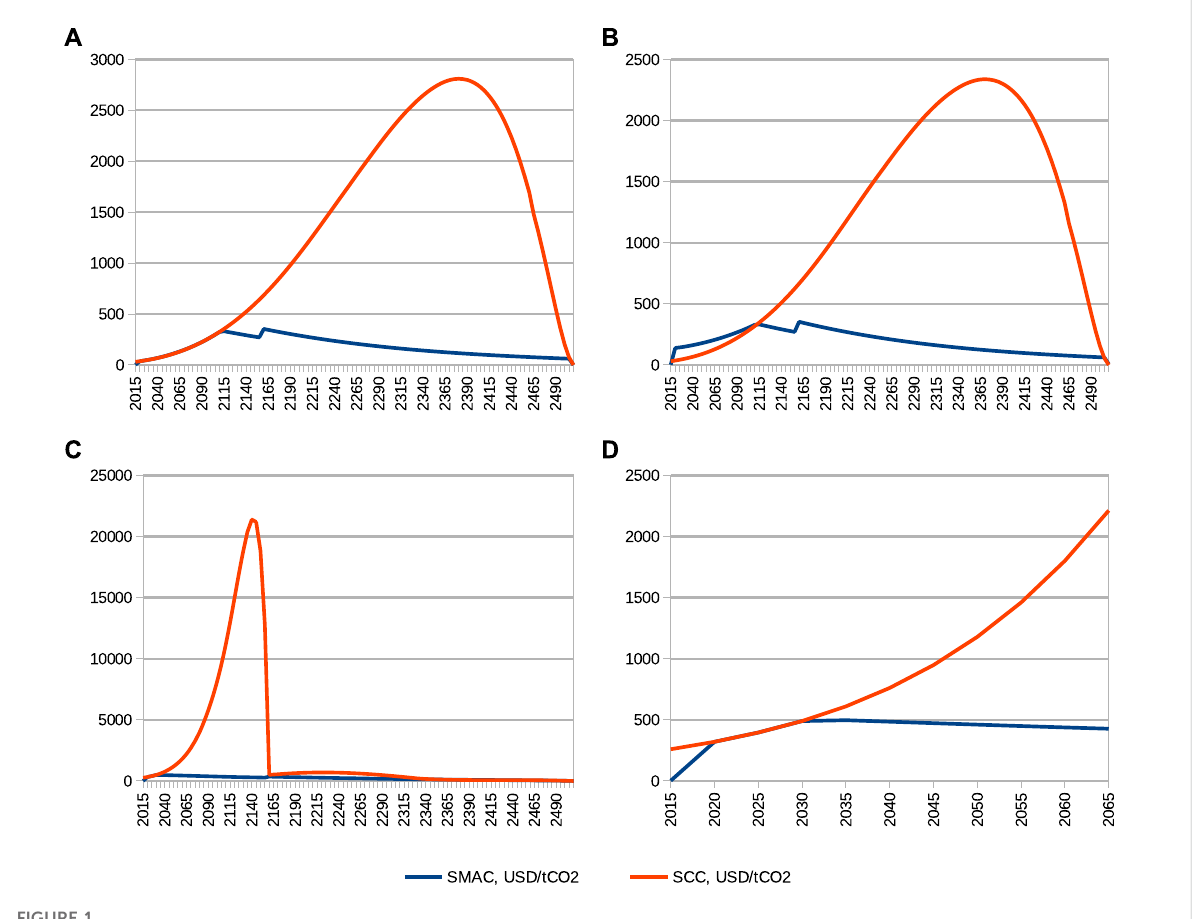
FIGURE 1 Social cost of carbon (SCC) and socially optimal marginal abatement cost of carbon (SMAC) as estimated by (A) the unmodi fi ed DICE 2016 model, (B) DICE 2016 model with a 70% cap on industrial emissions (C) DICE 2016 model with added temperature constraint T < 2.4 ° C, and (D) same as (C) yet zoomed into a shorter 50-year time period 2015 –